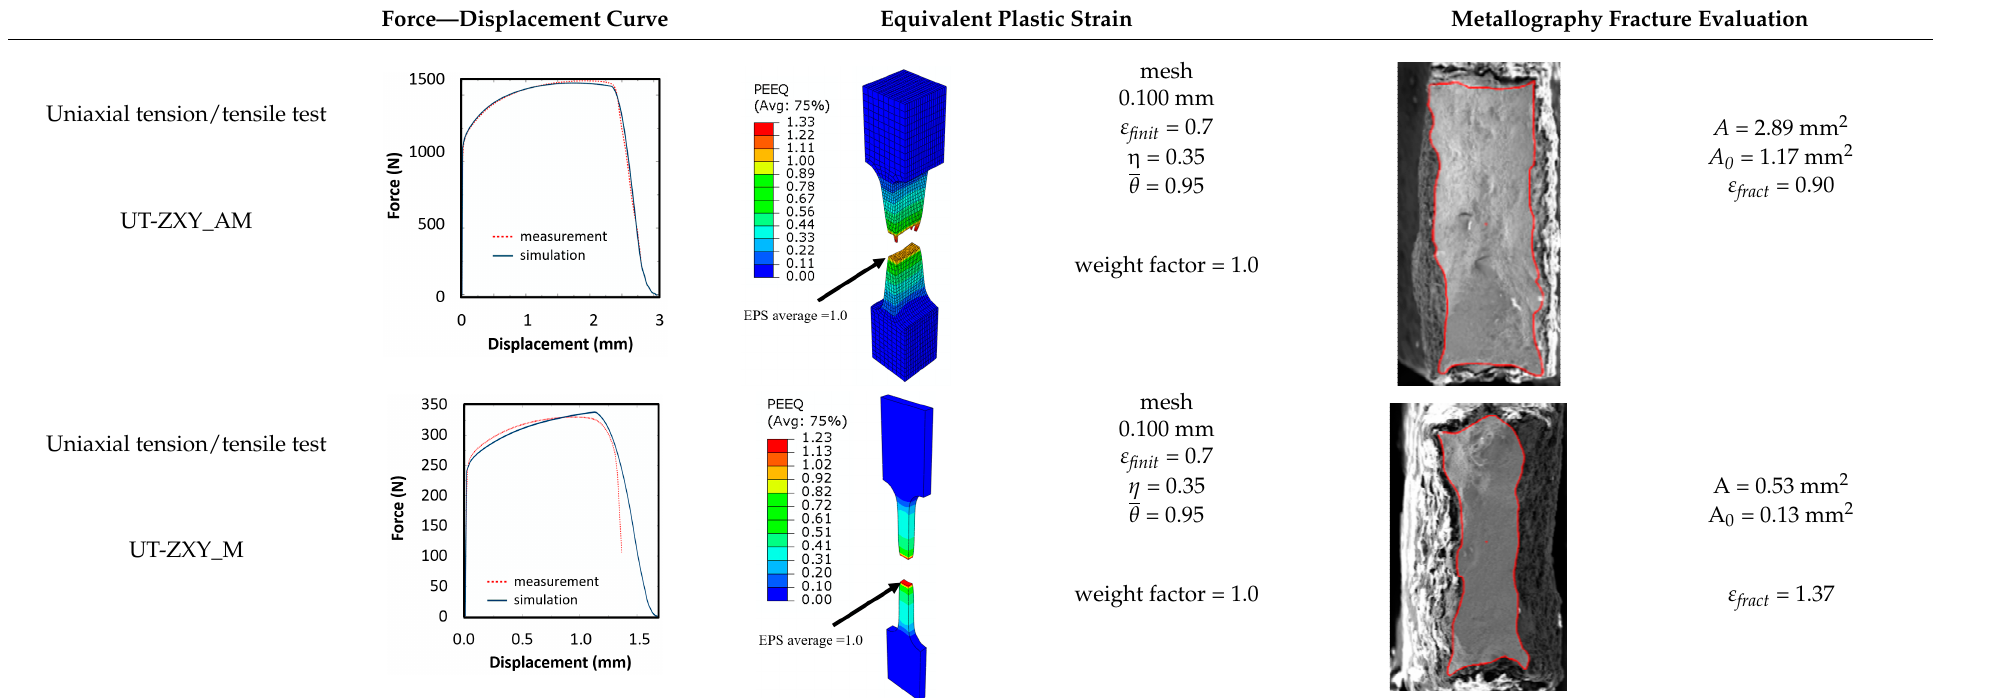
Table 4. Results of experimental and numerical investigation—comparison of stress-strain curves obtained by experimental measurement and simulation, equivalent plastic strain evaluation and metallographic fracture evaluation (if applicable) of the samples under uniaxial, plane strain and biaxial tension and uniaxial compression.